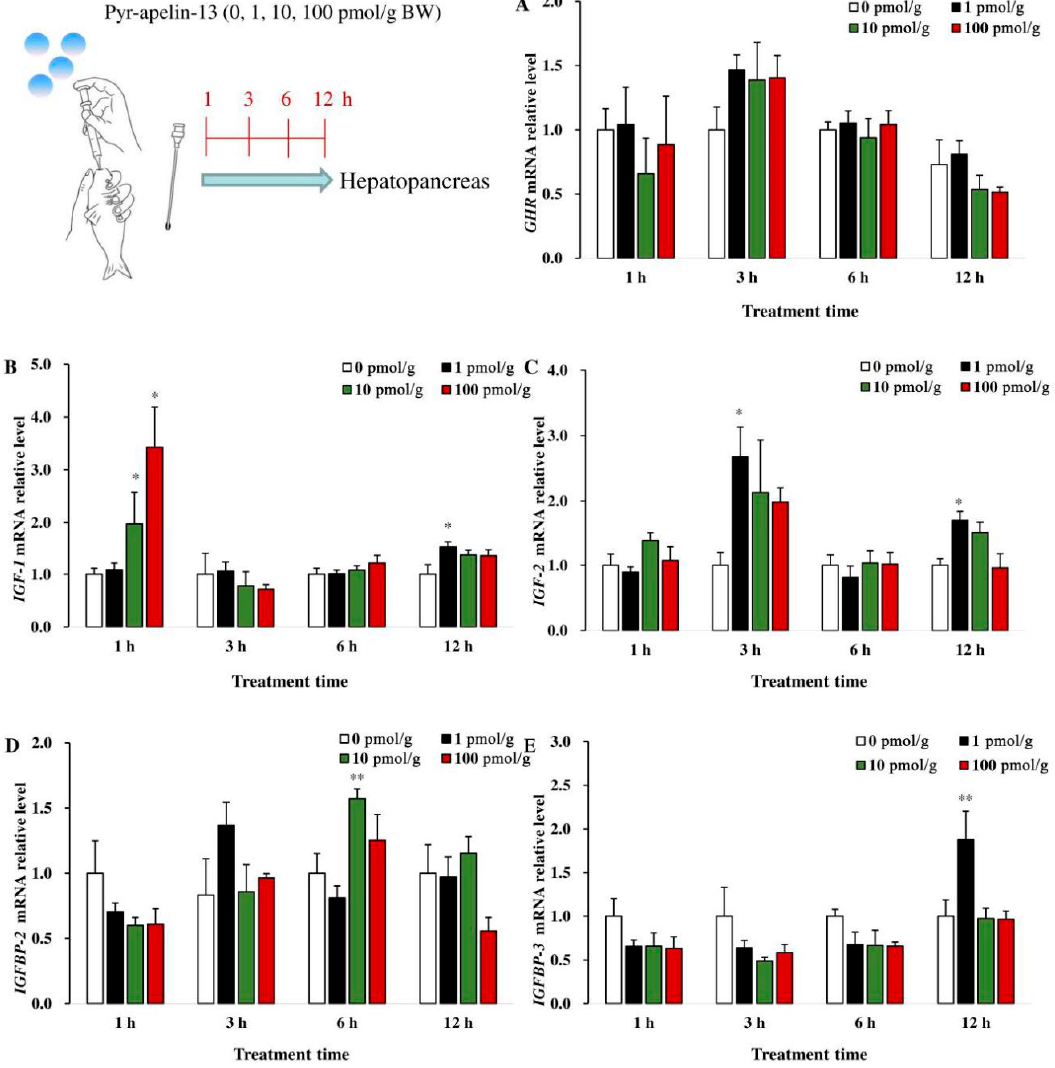
Figure 4. Gene expressions of growth-related factors in the hepatopancreas of Cyprinus carpio L. after gavage of Pyr-apelin-13 (0, 10, 100, and 1000 pmol/g). GHR ( A ), IGF1 ( B ), IGF2 ( C ), IGFBP2 ( D ), IGFBP3 ( E ). Differences between treatment and control groups at each time point were tested with Duncan’s multiple range test, and are indicated by different asterisks (* p < 0.05, ** p < 0.01). The data were given as mean ± SEM. ( n = 6).